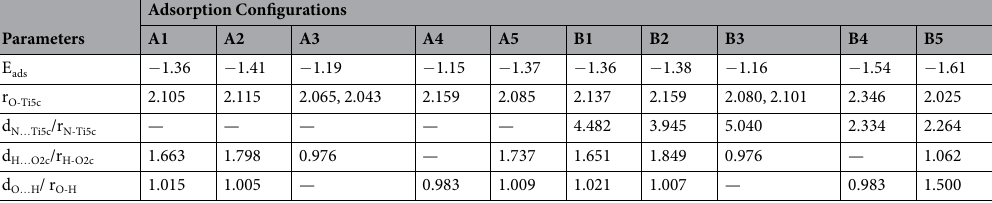
Table 1. The calculated adsorption energies E ads (eV), selected bond lengths (r in Å) and bond distances (d in Å) for the five most stable adsorbed structures of model dyes without cyano (A series) and with cyano group (B series) on the TiO 2 anatase (101) surface.